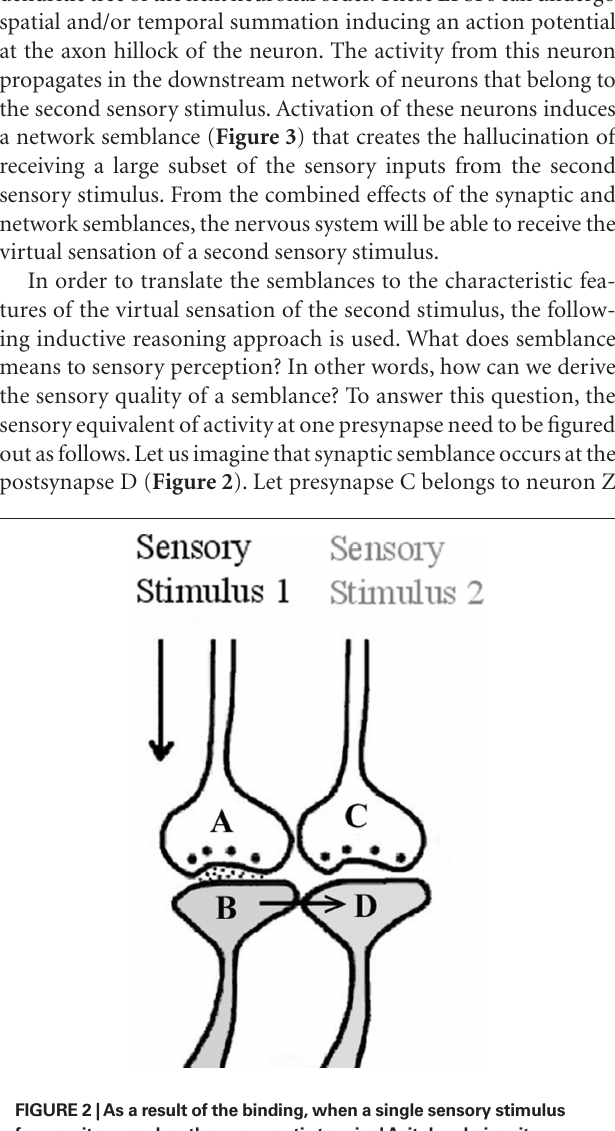
FIgure 2 | As a result of the binding, when a single sensory stimulus from an item reaches the presynaptic terminal A, it depolarizes its postsynaptic membrane B, and the resulting ePSP spreads through the functional LINK to postsynaptic membrane D. This evokes the cellular hallucination at postsynapse D of an action potential reaching its presynaptic terminal, C. This is called “synaptic semblance”. Note that a functional LINK can be reactivated by EPSP reaching it from either postsynapse B or D (This figure is used after modification (Vadakkan, 2008) with permission from iUniverse publishers, Bloomington, IN,